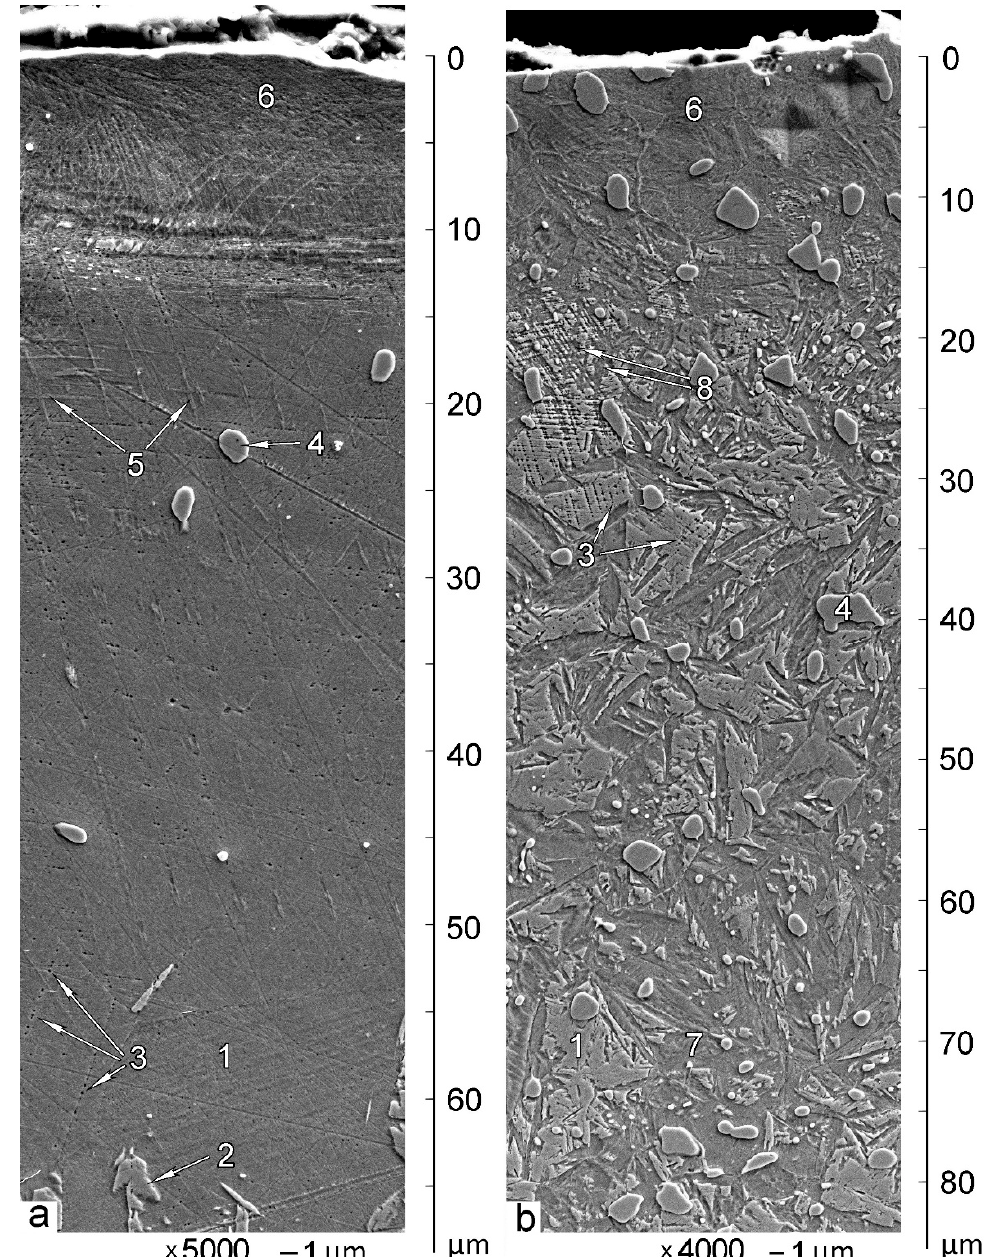
Figure 2. Microstructure of subsurface zones of X120Mn3Si2 steel after quenching and wear in B mode: ( a ) quenching from 1000 °C; ( b ) quenching from 900 °C; 1—austenite; 2—polishing-induced martensite; 3—etch pits; 4—carbides; 5—presumably transformation-induced martensite along slip planes; 6—surface zone formed by abrasive wear; 7—as-quenched martensite; 8—zone of ultimate plastic deformation of austenite. The prints in the upper right corner on image ( b ) were not used for microhardness calculation.